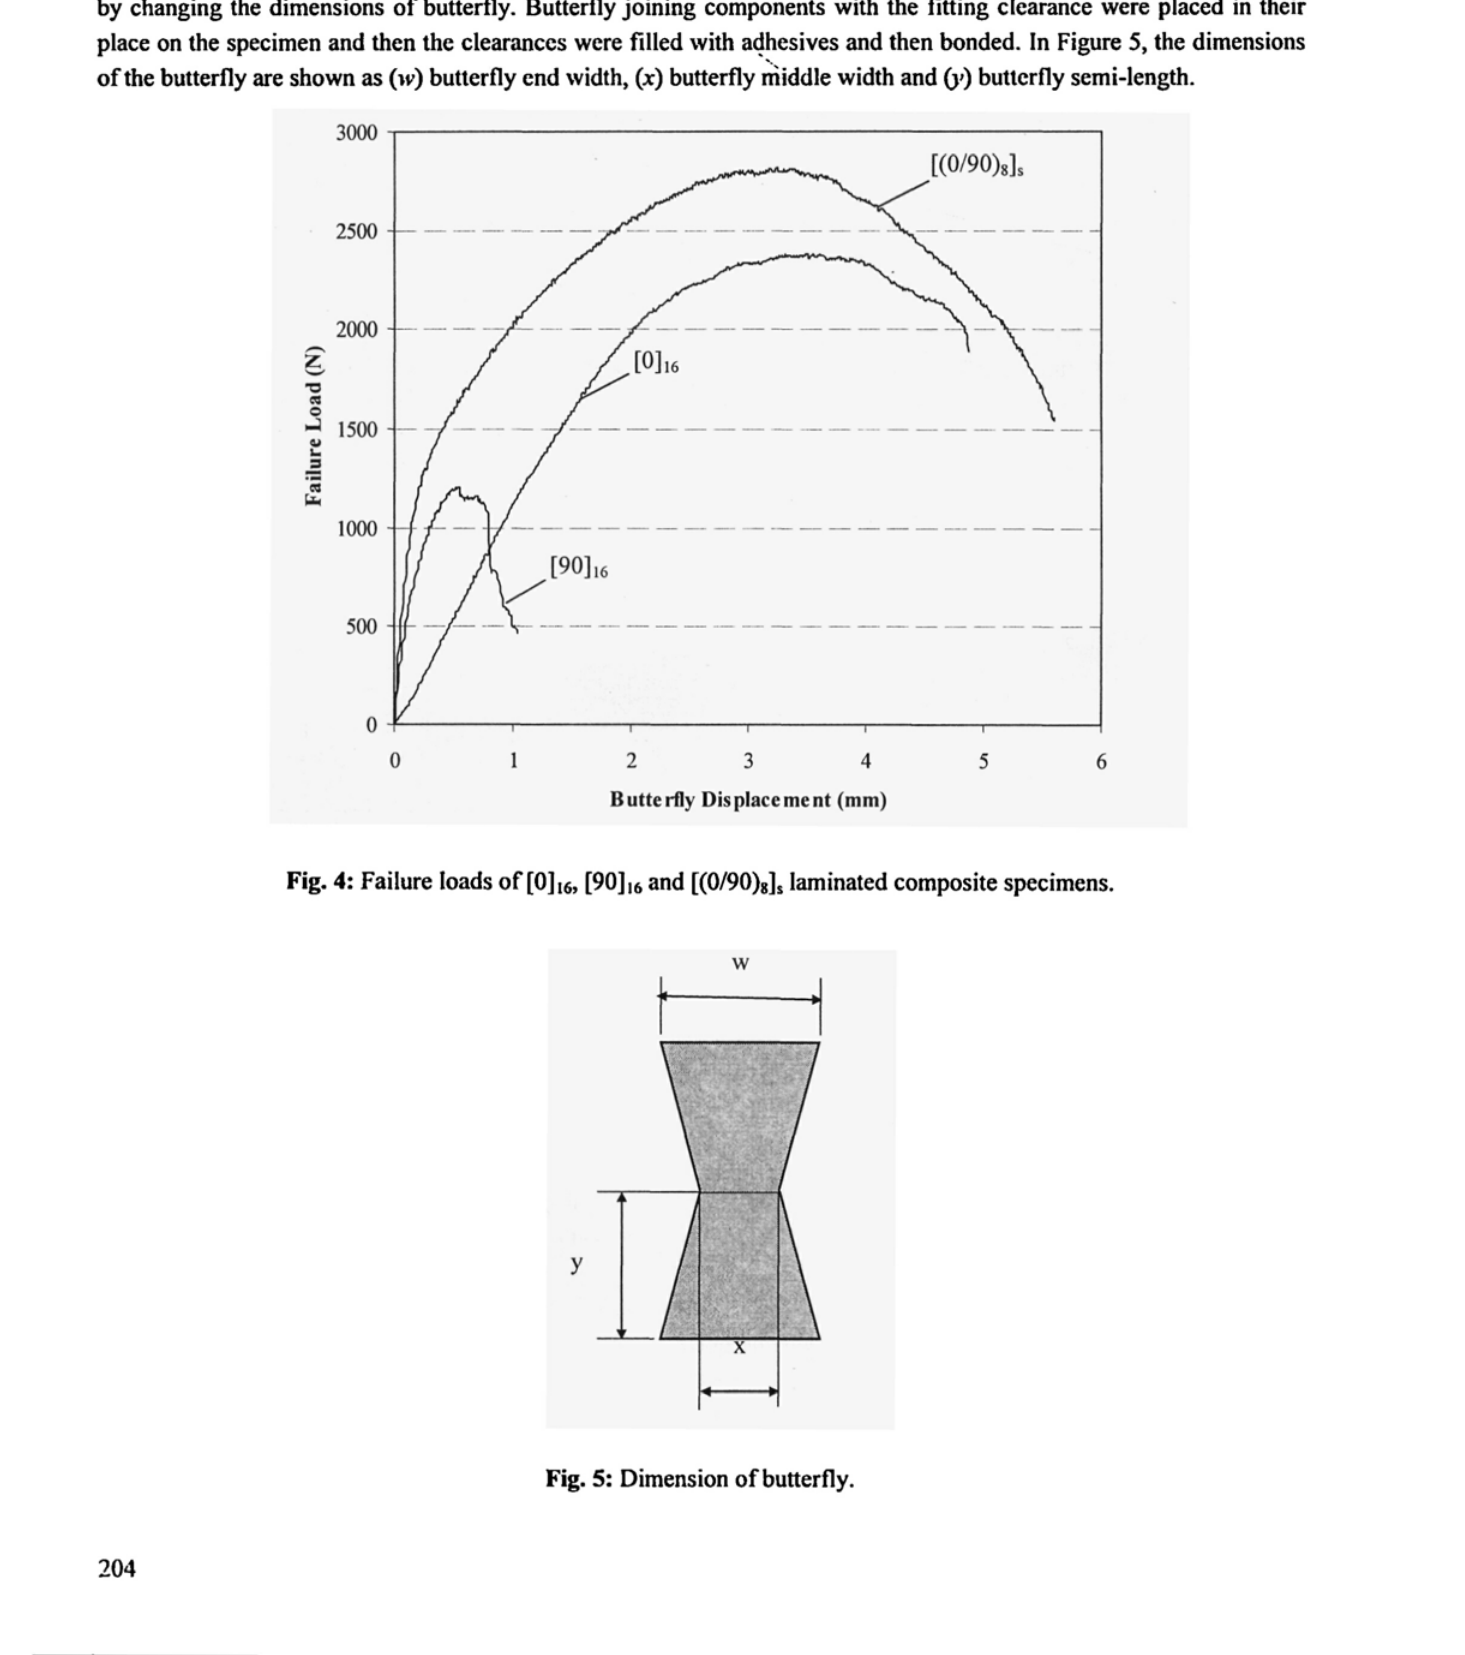
Fig. 5: Dimension of